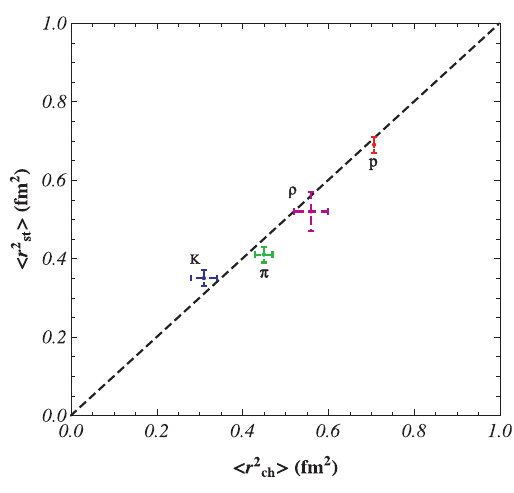
(cid:6) and the charge radius (cid:4) r 2 (cid:6) for light st ch